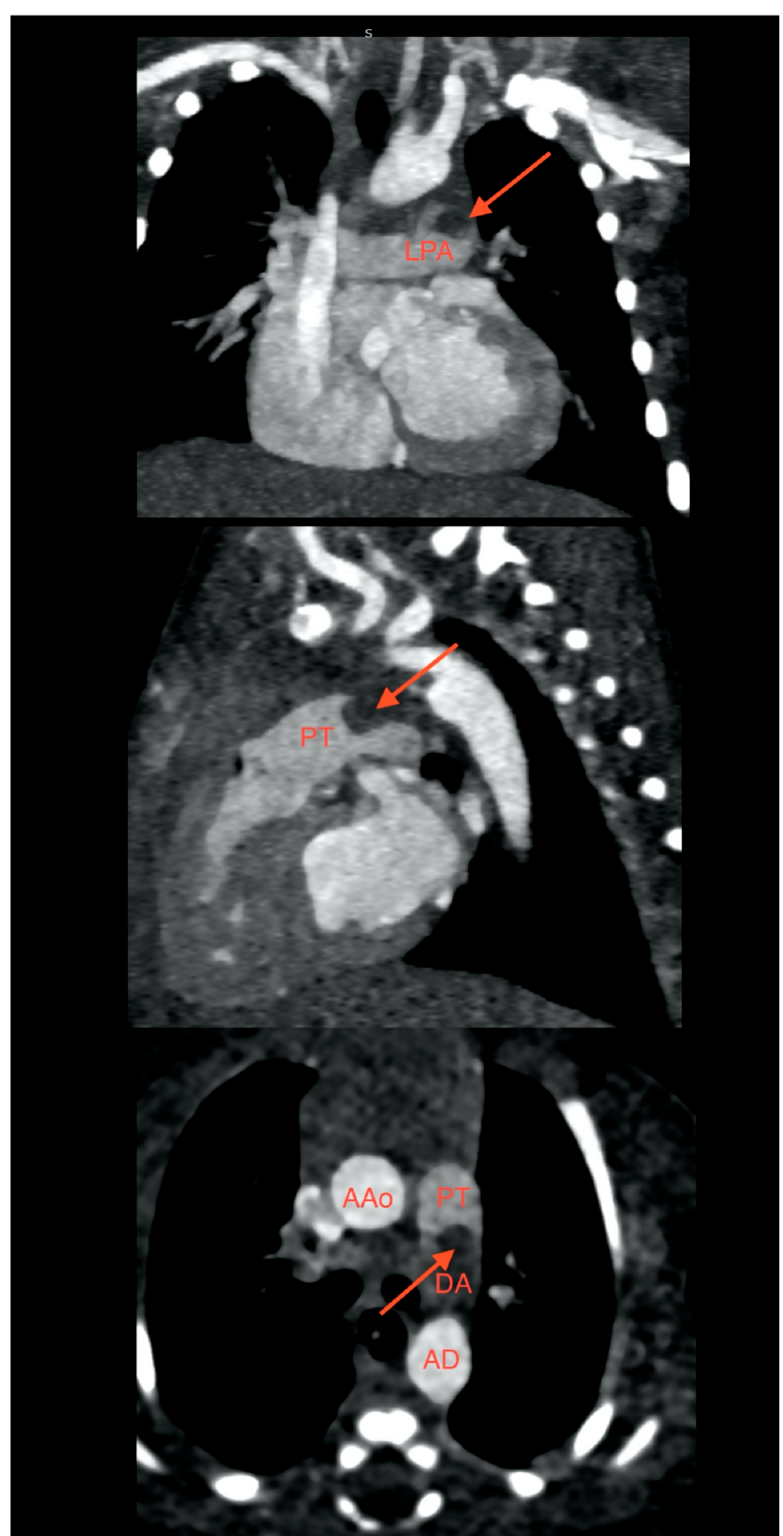
Figure 1. Angio-CT scan of 4-day-old neonate presenting thrombus extending into the left pulmonary artery, pulmonary trunk, and arterial duct. LPA: Left pulmonary artery; PT: Pulmonary trunk; DA: Arterial duct; AAo: Ascending aorta; AD: Descending aorta.